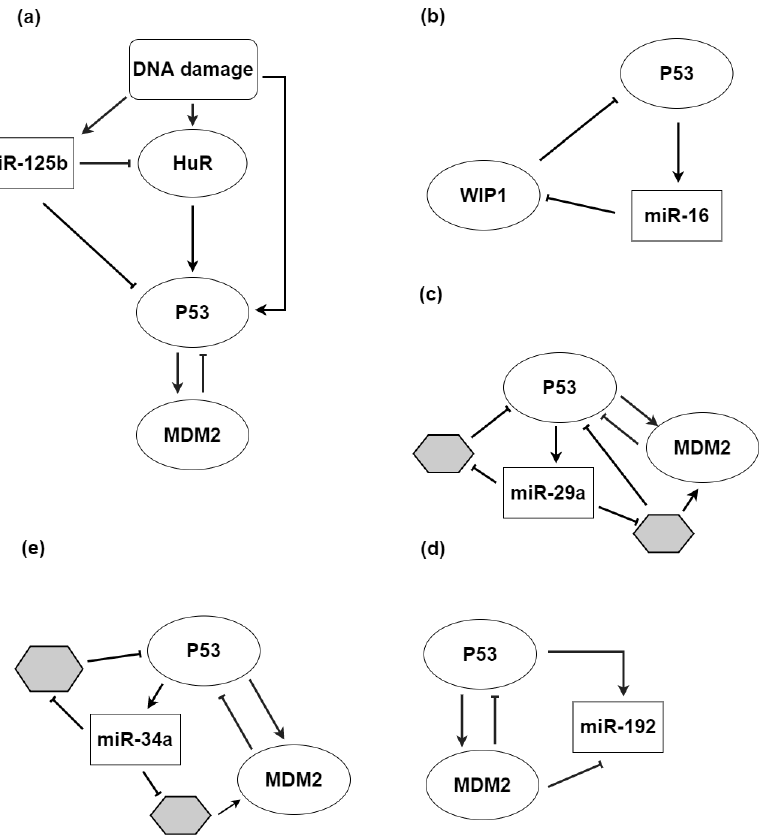
Figure 4. Examples of p53-governed regulatory networks involving miRNAs. Edges with a pointed head represent positive (activatory) regulation, whereas edges with a flat head represent negative (repressive) regulation. ( a ) Representation of interactions between p53, miR-125b, MDM2, and the RNA-binding protein HuR. Mir-125b contributes to the p53 pulse generation subsequent to UV irradiation by concomitantly targeting p53 and Hur. ( b ) Representation of the positive feedback loop between p53 and Wip1, mediated by miR-16. MiR-16 contributes to the discrimination between cell death and senescence. ( c – e ) Networks involving miR-192, miR-34a, miR-29a, and the p53-MDM2 module. Grey hexagons represent further elements constituting the networks. The three miRNAs confer robustness to the networks by tuning p53 temporal